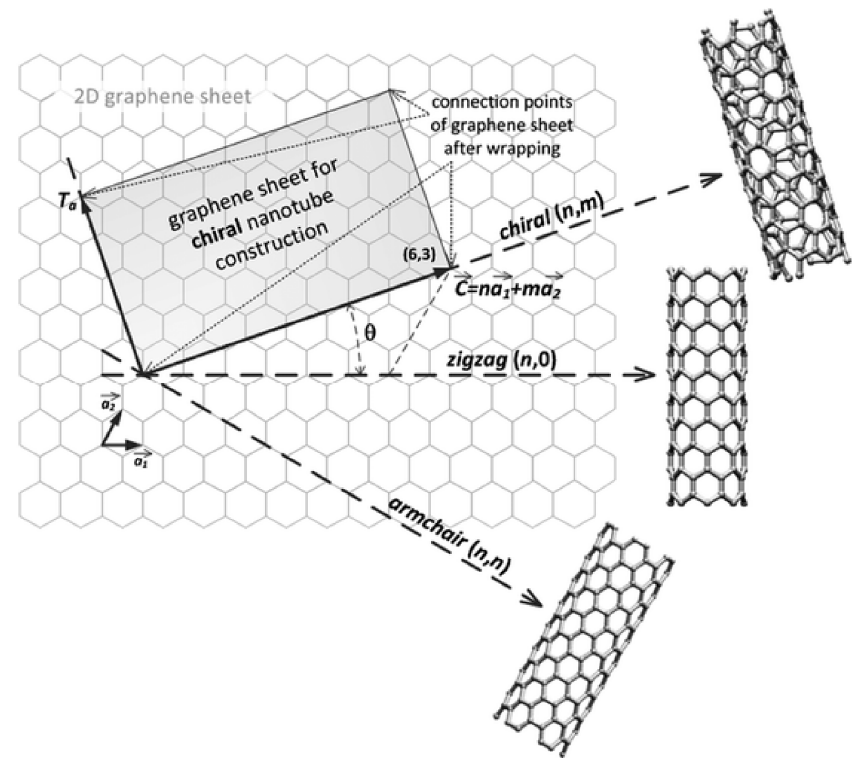
Figure 4. Theoretical folding of a perfect graphene sheet according to different linear combinations of the chiral vectors, leading to the three main CNT structures, named armchair, zig-zag and chiral. Reprinted with permission from Sanginario et al. [55] under CC BY license.